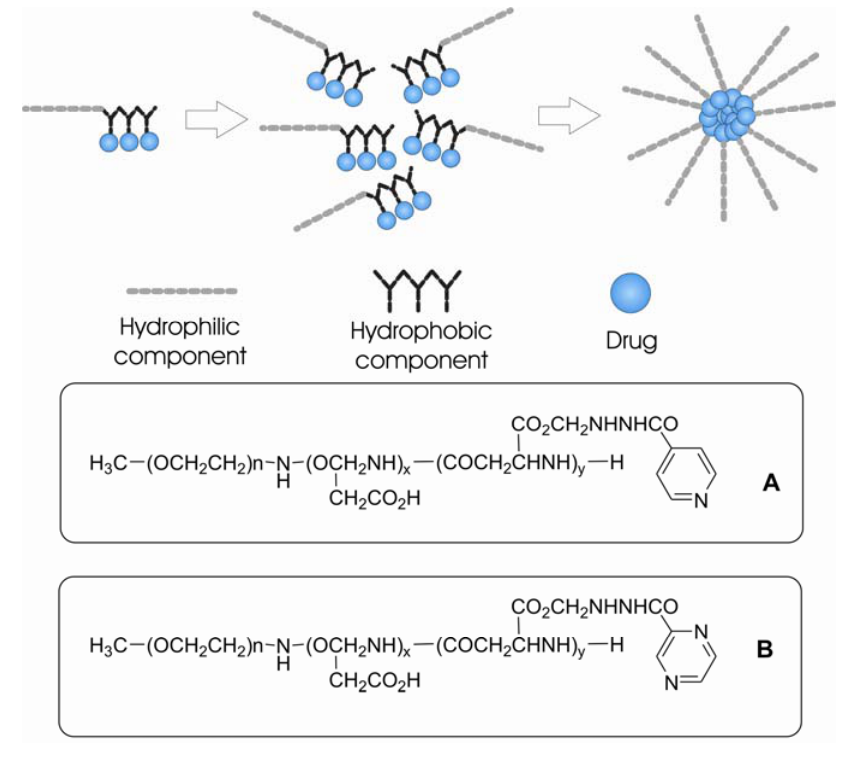
Figure 41 . Micelles of PEG-PAS covalently linked to drugs. A. isoniazide; B: